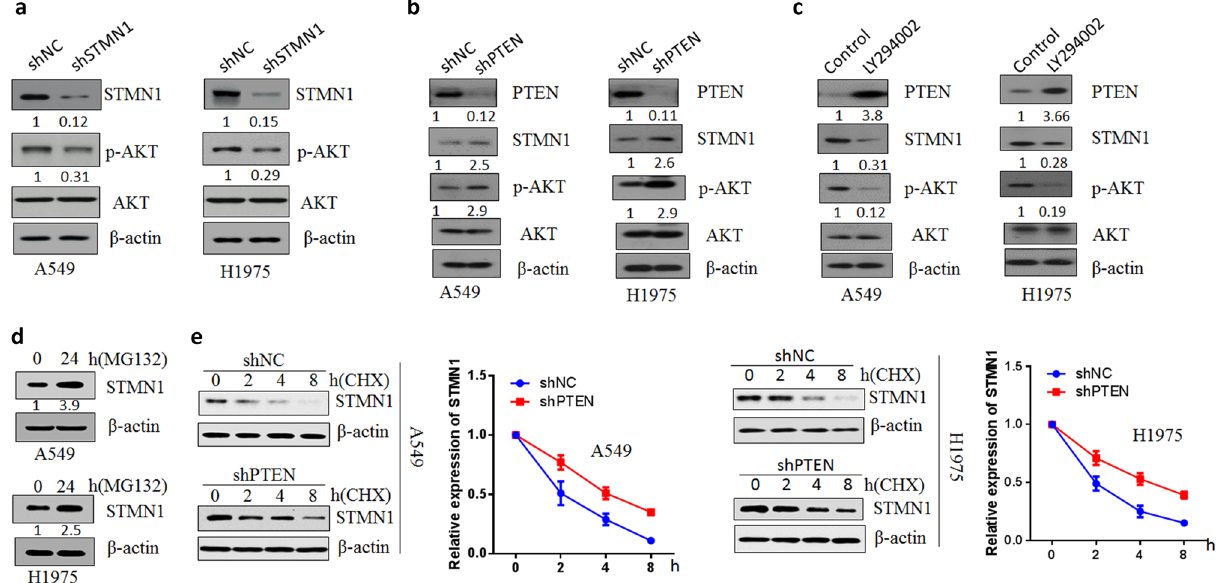
Figure 4. PTEN loss promoted STMN1 expression via PI3K/AKT pathway. ( a ) Western blotting analysis of STMN1, p-AKT and AKT protein levels in A549 and H1975 cells transfected with STMN1 shRNA and negative control plasmids. Full-length images are presented in Supplementary Fig. 4. ( b ) Protein levels of PTEN, STMN1, p-AKT and AKT were detected via western blotting in A549 and H1975 cells transfected with PTEN shRNA and negative control plasmids. Full-length images are presented in Supplementary Fig. 5. ( c ) Western blotting analysis of PTEN, STMN1, p-AKT and AKT protein levels in A549 and H1975 cells treated with PI3K-kinase inhibitor LY294002. Full-length images are presented in Supplementary Fig. 6. ( d ) A549 and H1975 cells were treated with MG132. Full-length images are presented in Supplementary Fig. 7. ( e ) A549 and H1975 cells with or without PTEN knockdown were treated with CHX (cycloheximide, CHX) (10 µg/mL). Western blotting was used to analyze the protein level of STMN1. Full-length images are presented in Supplementary Fig.